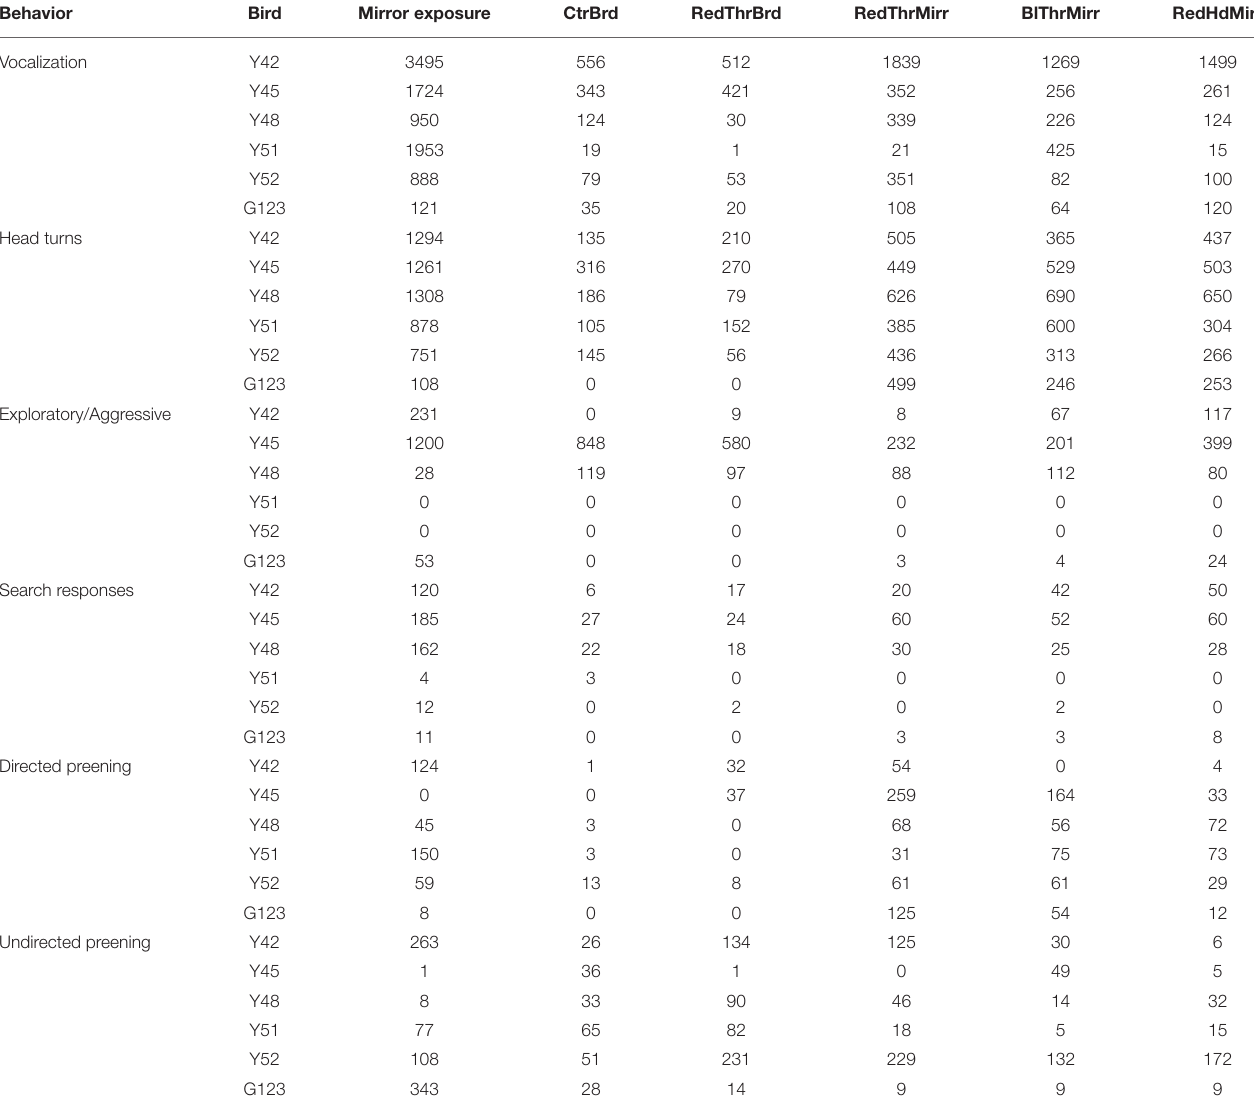
TABLE 1 | Various behaviors performed by male zebra finches during mirror self-recognition experiments. Behavior Bird Mirror exposure CtrBrd RedThrBrd RedThrMirr BlThrMirr RedHdMirr